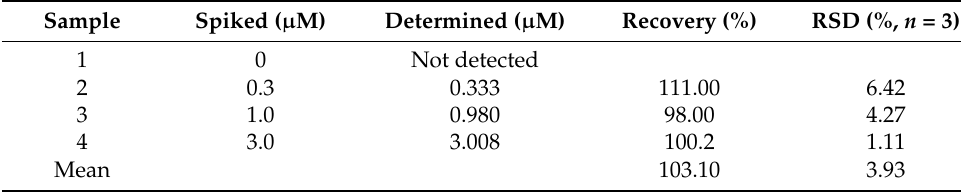
Table 1. Determination of amoxicillin in breast milk samples.